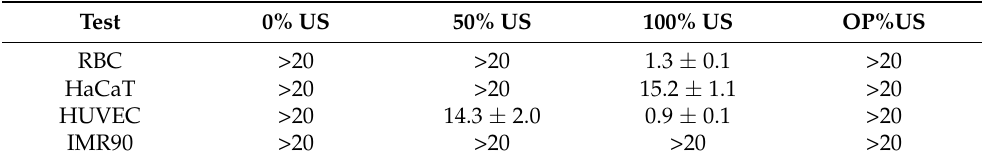
Figure 6. Hemolytic activity of the extracts on human erythrocytes ( A ), toxicity induced by 48 h exposure of human cells HaCaT ( B ), HUVEC ( C ), and IMR90 ( D ) to extracts at increasing concentration. In all cases, results correspond to means ± SD ( n = 3) and were fitted using the Graph Pad Prism software. Table 2. Half maximal hemolytic concentration (HC 50 ) and half maximal cytotoxic concentration (IC 50 ) (mg/mL) of the extracts on human cells. HC 50 and IC 50 were calculated from Figure 6 using Graph Pad Prism software. Values are expressed as means ± SD.